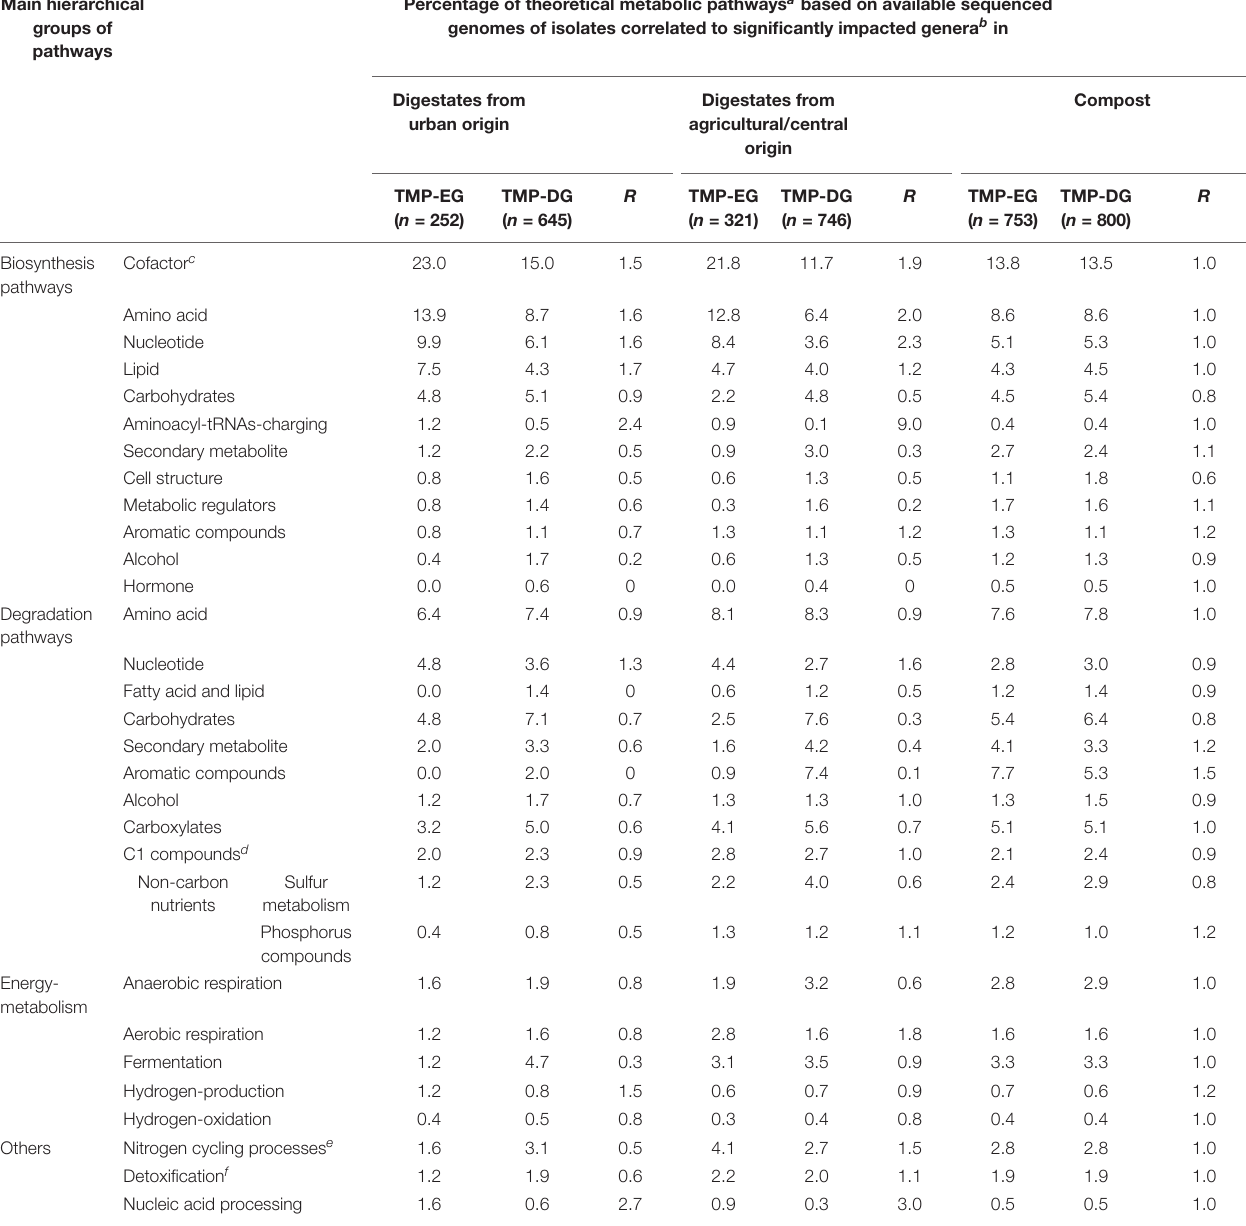
Main hierarchical groups